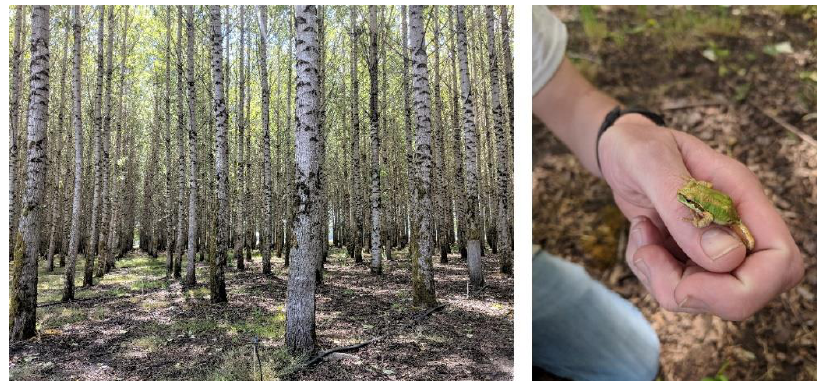
Figure 4. The City of Chehalis Poplar Plantation, where the trees are irrigated with reuse water during the dry months, has other environmental benefits like wildlife habitat.